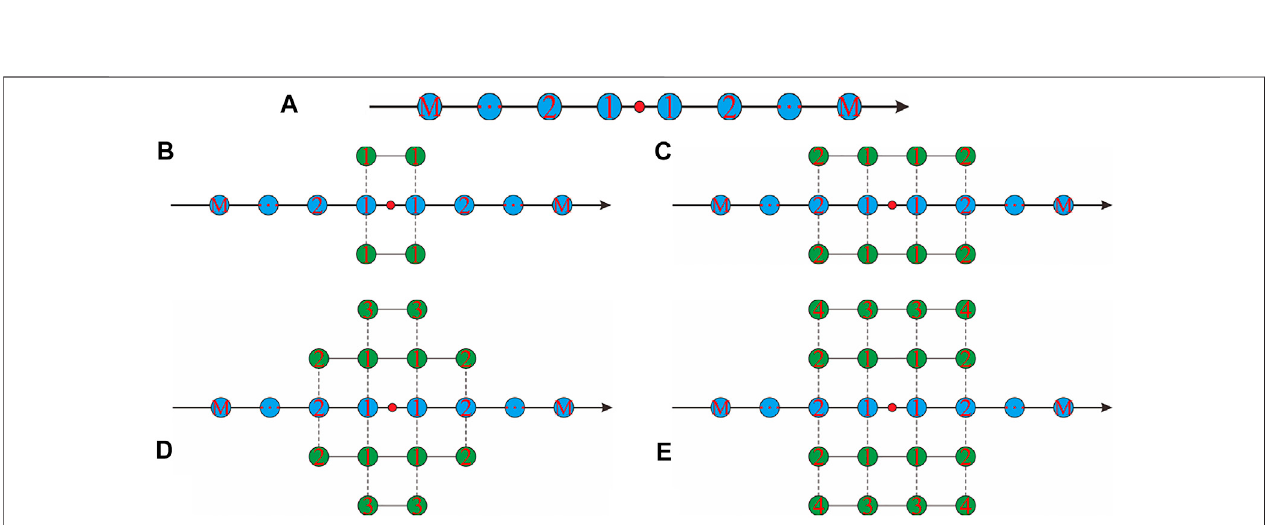
FIGURE 2 | Schematic representation of the spatial FD operators of (A) C-SFD and (B – E) M-SFD ( N =1, 2, 3, and 4).